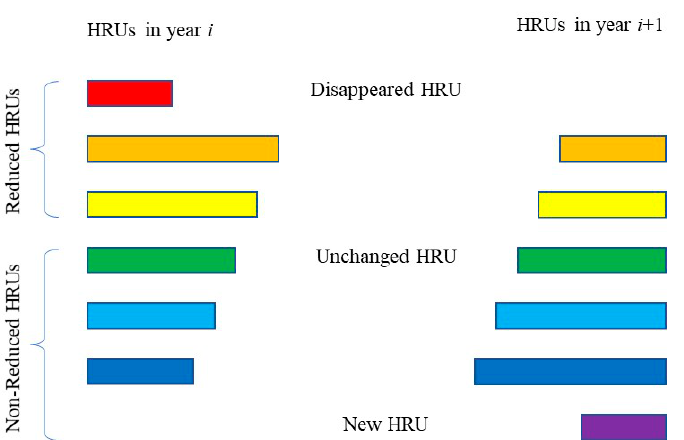
Figure 4. Typical schematic diagram of hydrological response units (HRUs) from the same sub- watershed in two adjacent years. The length of the bar represents the area of the HRU, and different colors represent different HRUs. In this schematic example, there are 3 reduced HRUs and 4 non-reduced HRUs.